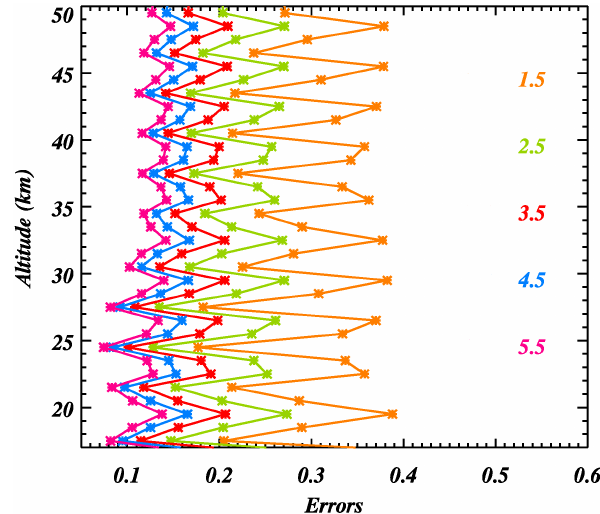
Fig. 8. Number density profiles with different Tikhonov parame- ters: The coloured lines are the retrieved water vapor profiles us- ing different Tikhonov values and the grey lines in each panel are the a priori profiles. Tihkonov parameter 3.5 was selected for the retrieval (Measurement: 13 March 2006, orbit=21085, SZA=109.137, moon phase=0.93).